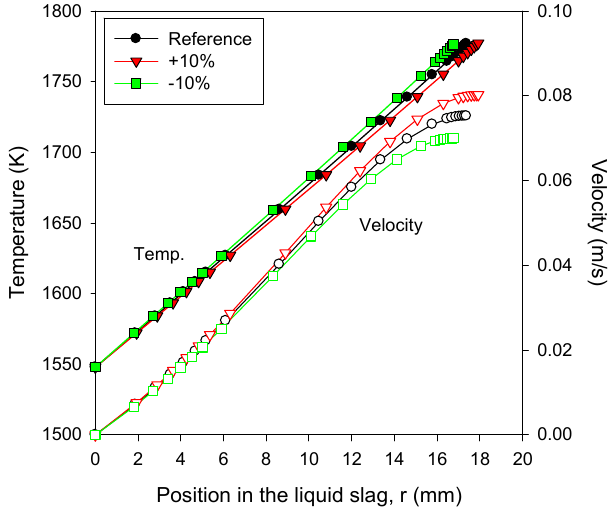
Figure 4. Effects of ash deposition rate on temperature and velocity profiles of liquid slag at the slag tap.